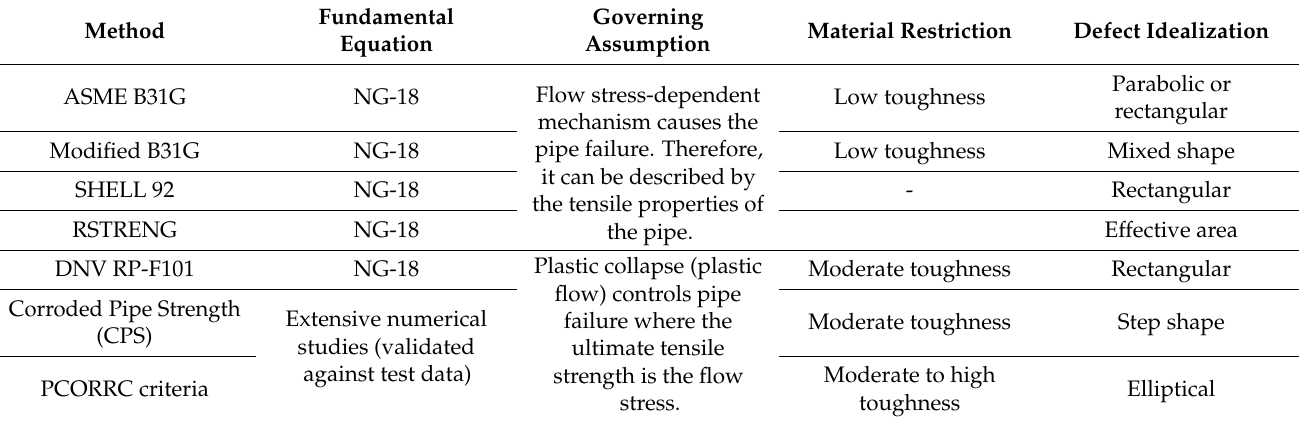
Table 1. Common pipe failure pressure assessment methods [6,9,13].